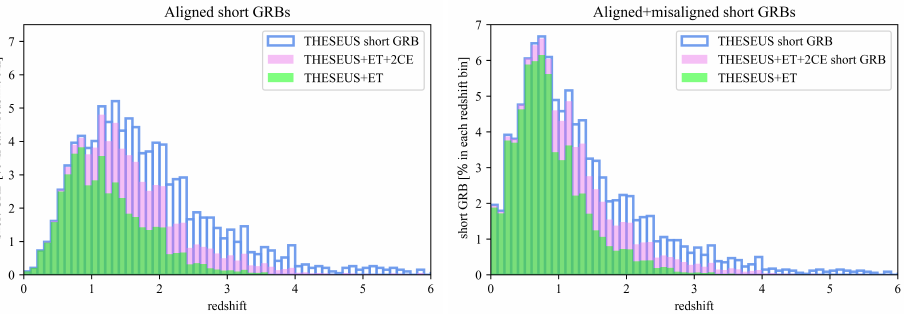
Figure 4. ( Left ): Short GRB redshift distribution detected with THESEUS/XGIS assuming an on-axis configuration (blue) and jointly with ET (green) and a network of 3G composed by 2CE and ET (pink). ( Right ): Same figure but now Short GRB with off-axis configurations are